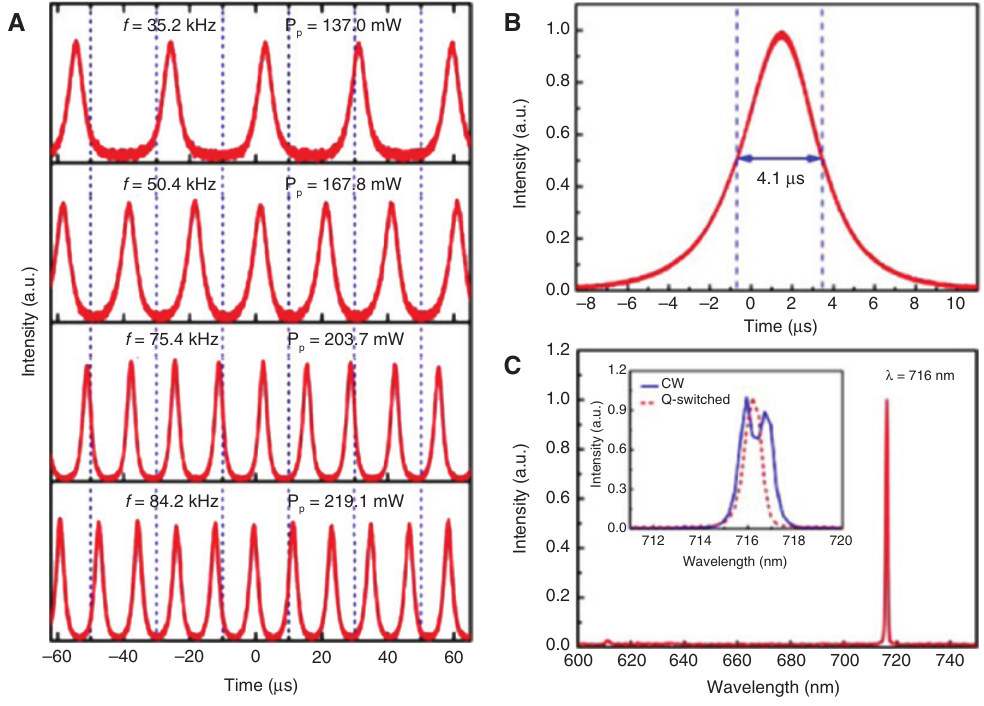
Figure 5: Characteristics of the deep-red fiber laser. (A) Typical pulse trains versus the incident pump power, (B) Typical pulse profile with a duration of 4.1 μ s and (C) the corresponding spectrum of the deep-red CNTs Q-switched Pr:ZBLAN laser. Baek et al. [9] © Optical Society of America 2017.